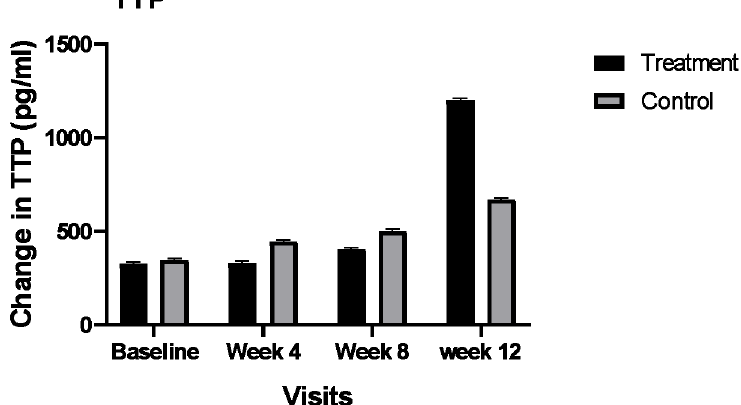
Figure 2. Comparison of mean plasma concentrations of TTP (pg/mL) between the treatment and control group during the 12 weeks of the study. Bars represent the means ± SEM.